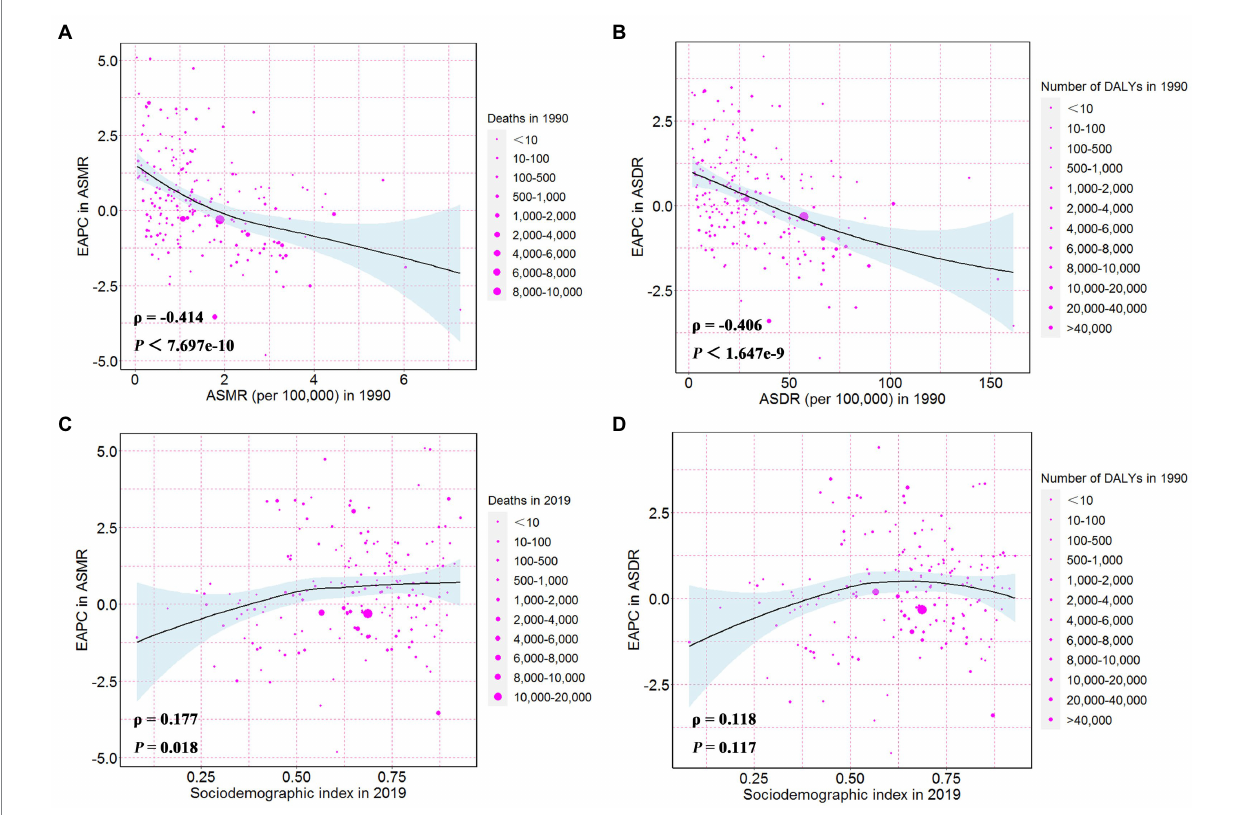
FIGURE 5 The influential factors for EAPC. (A) The correlation between EAPC in ASMR and ASMR in 1990. (B) The correlation between EAPC in ASDR and ASDR in 1990. (C) The correlation between EAPC in ASMR and sociodemographic index in 2019. (D) The correlation between EAPC in ASDR and sociodemographic index in 2019. The circles represent countries and the size of circle is increased with the number of chronic kidney disease-related deaths and DALYs attributable to high sodium intake. The ρ indices and p values presented in (C,D) were derived from Pearson correlation analysis. ASMR, age-standardized mortality rate; DALYs, disability-adjusted life years; ASDR, age-standardized DALYs rate; EAPC, estimated annual percentage